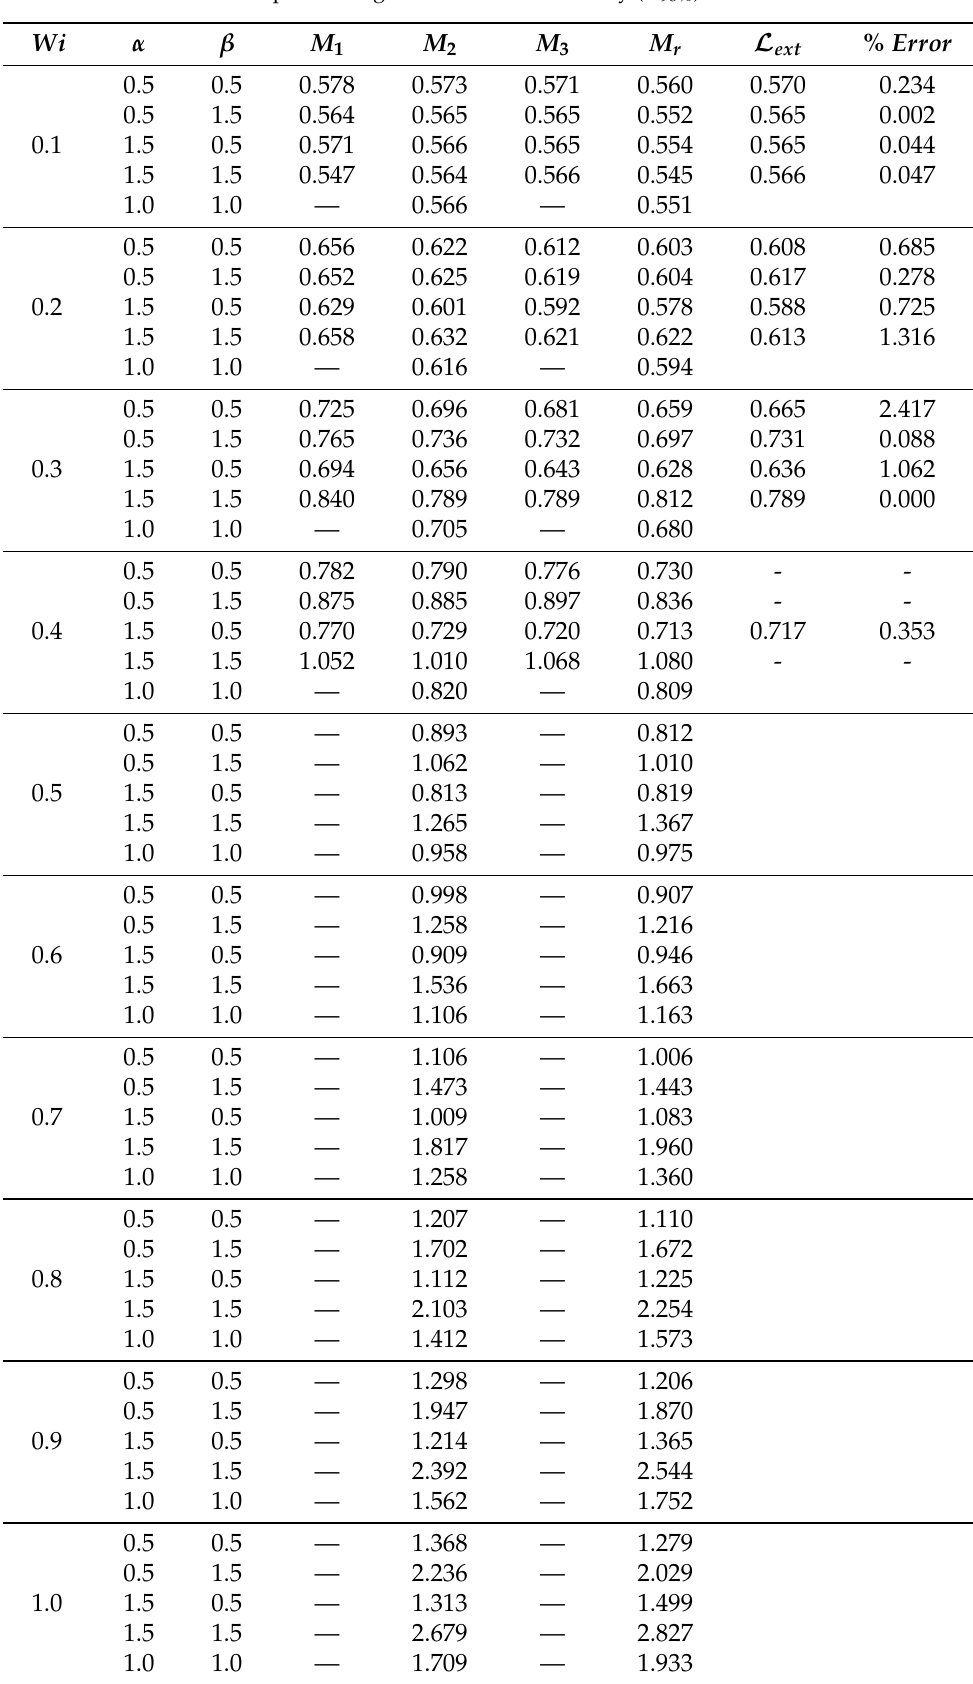
Table 2. Benchmark development length values for the velocity (